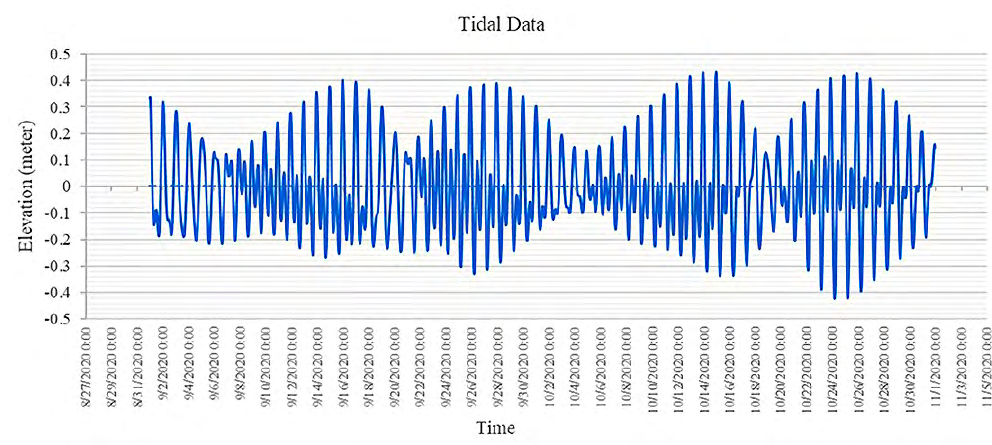
Figure 15. Tidal Data Used